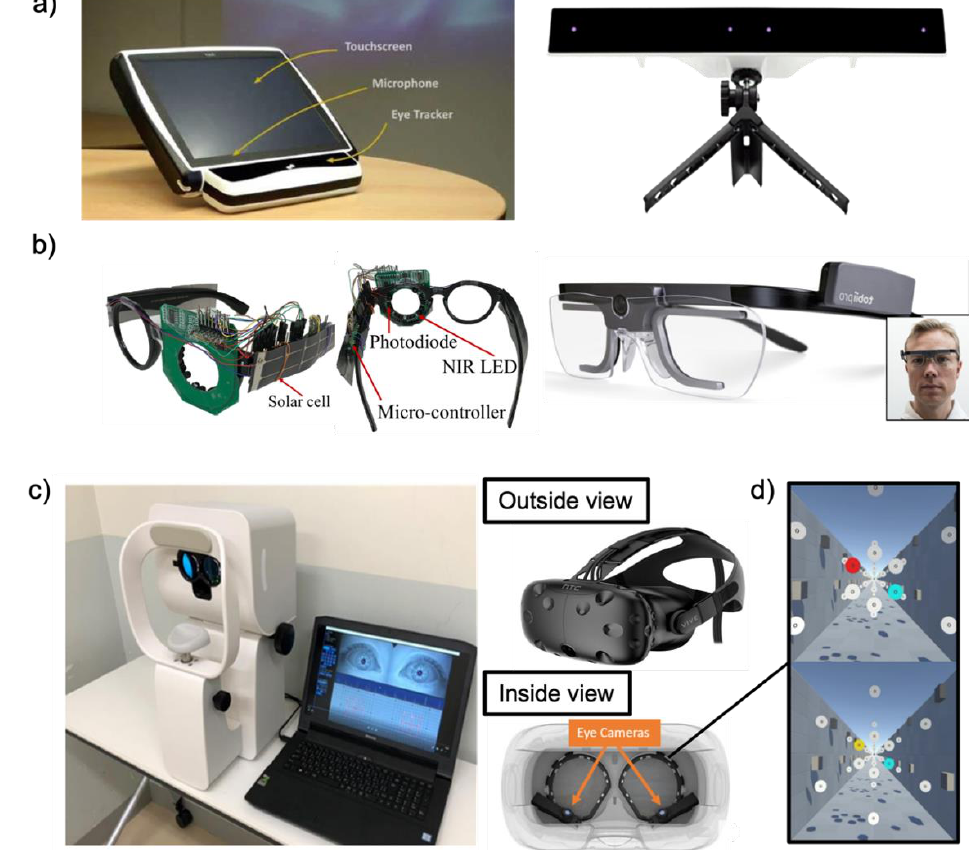
Figure 14. Eye tracking platforms. ( a ) Glass-type eye tracker (Left: Reprinted with permission [184].